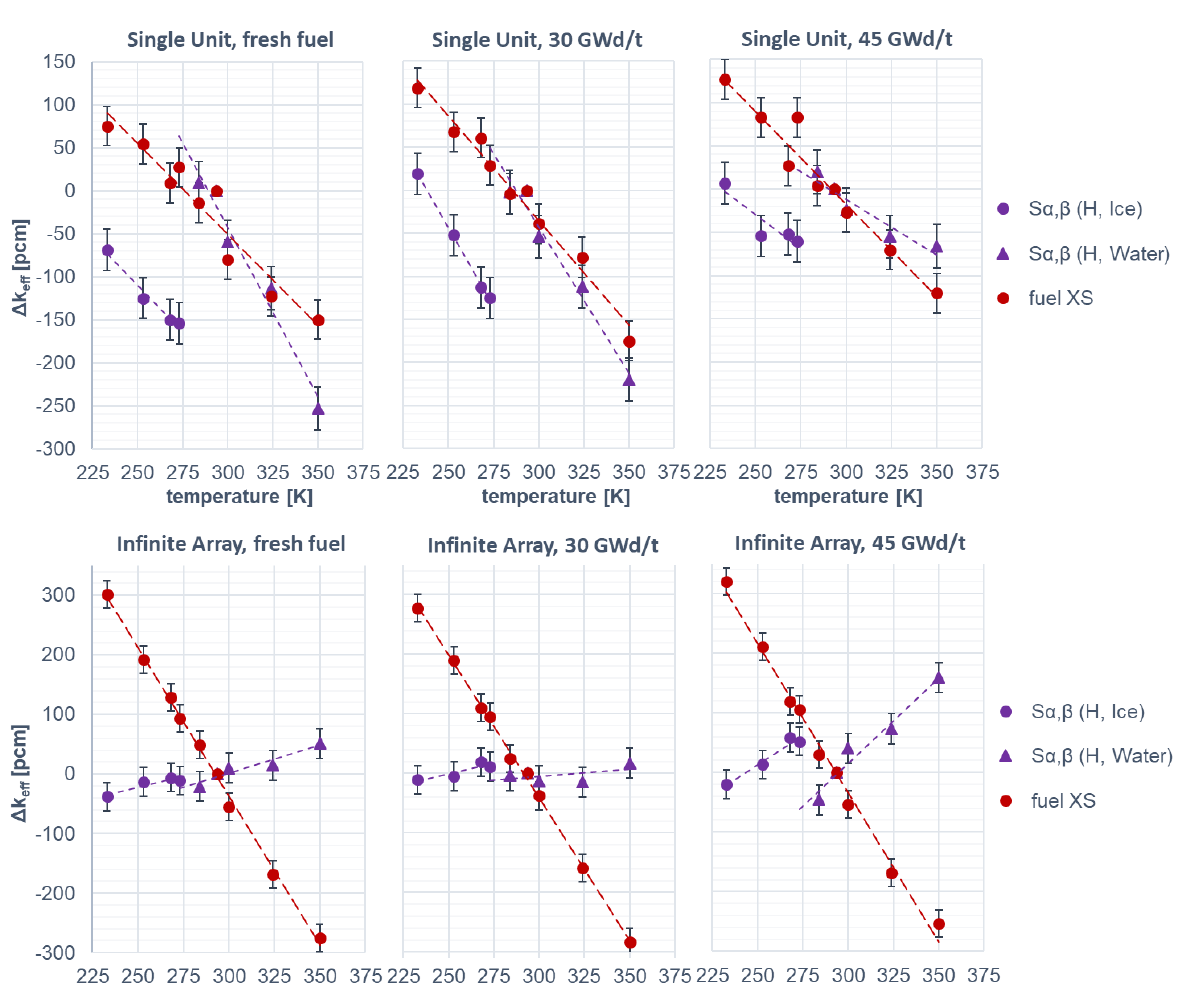
Figure 5. Temperature-dependent impact of the thermal scattering data of hydrogen (S reaction cross sections (XS) of the fuel on k